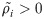
(A) Reciprocity scores (ρi) for within-bout (Δ < 0) grooming by chimpanzee (i): one out of twenty six individual chimpanzees exhibit significant asymmetry in grooming urations (ρi˜>0) at p = 0.05; (B) Reciprocity scores for delayed (Δ ≥ 0) grooming: all individuals show significant asymmetry (ρi˜>0) at p = 0.05; (C) Corresponding sample sizes.